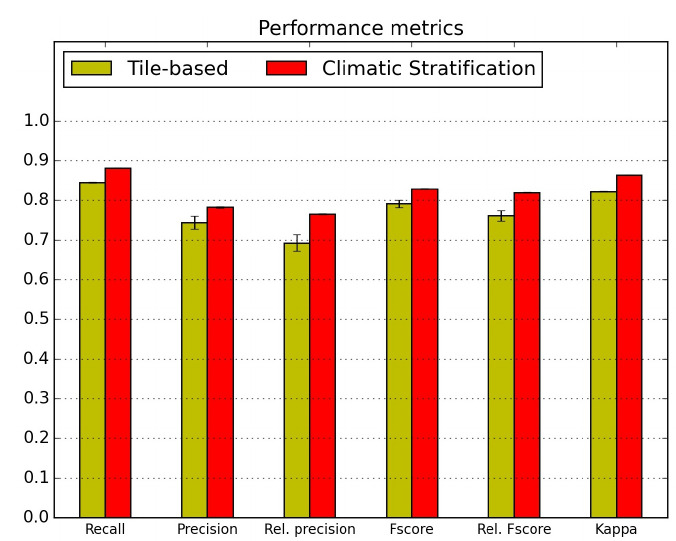
Figure 13. Performance metrics for the produced maps.